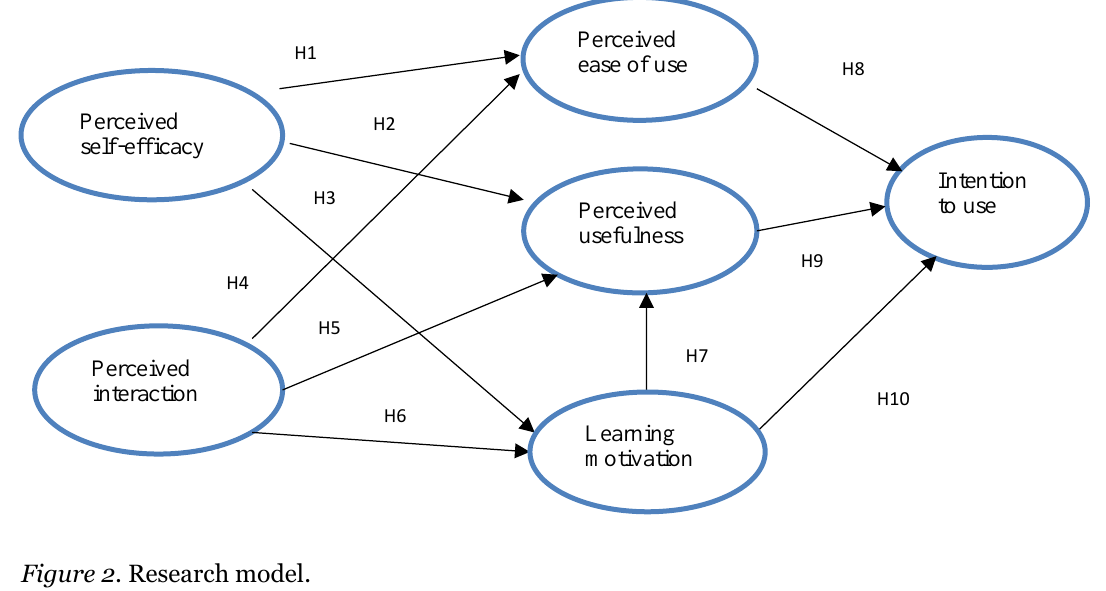
Figure 2. Research